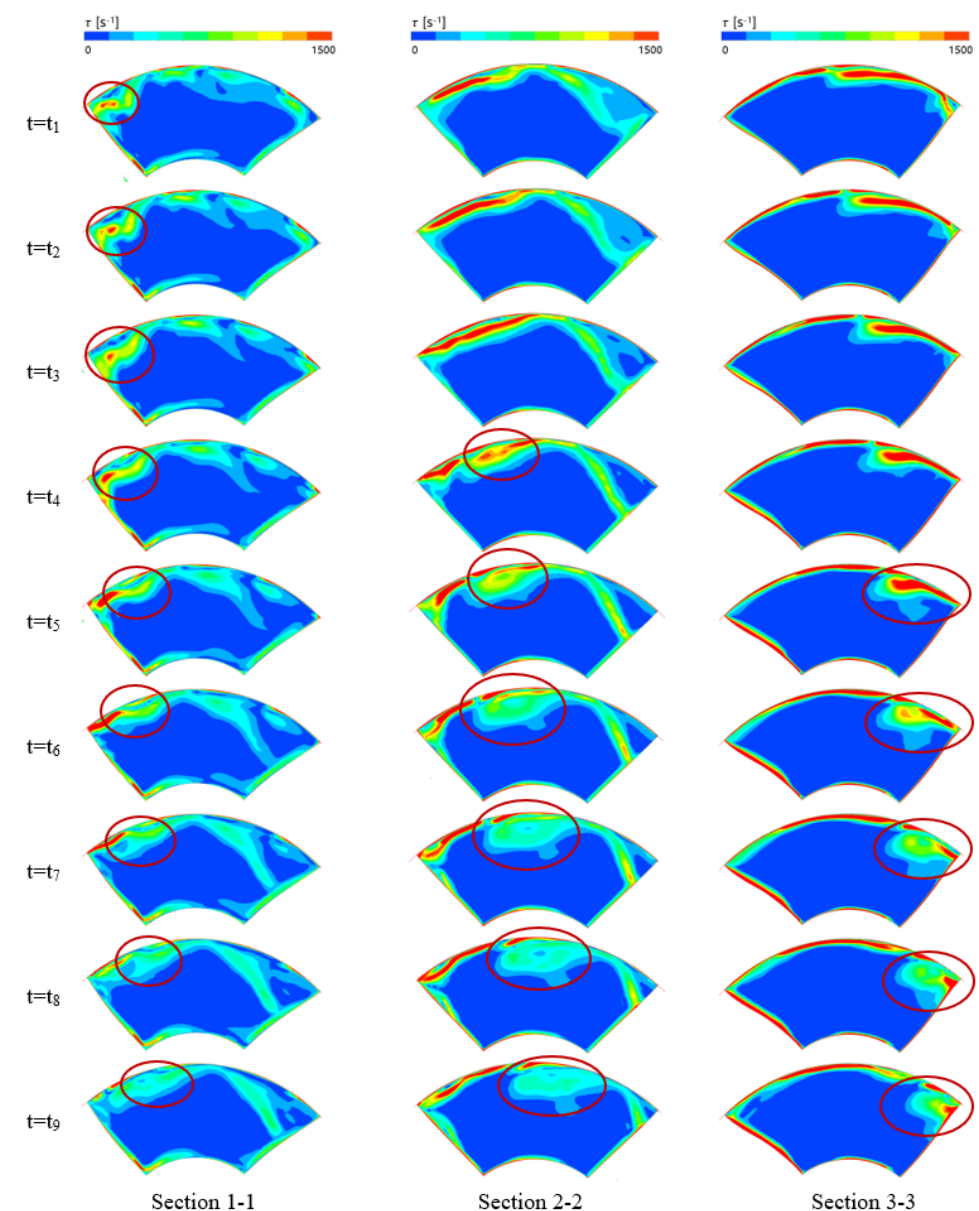
Figure 13. Velocity gradient changes of typical cross-sections at different times.